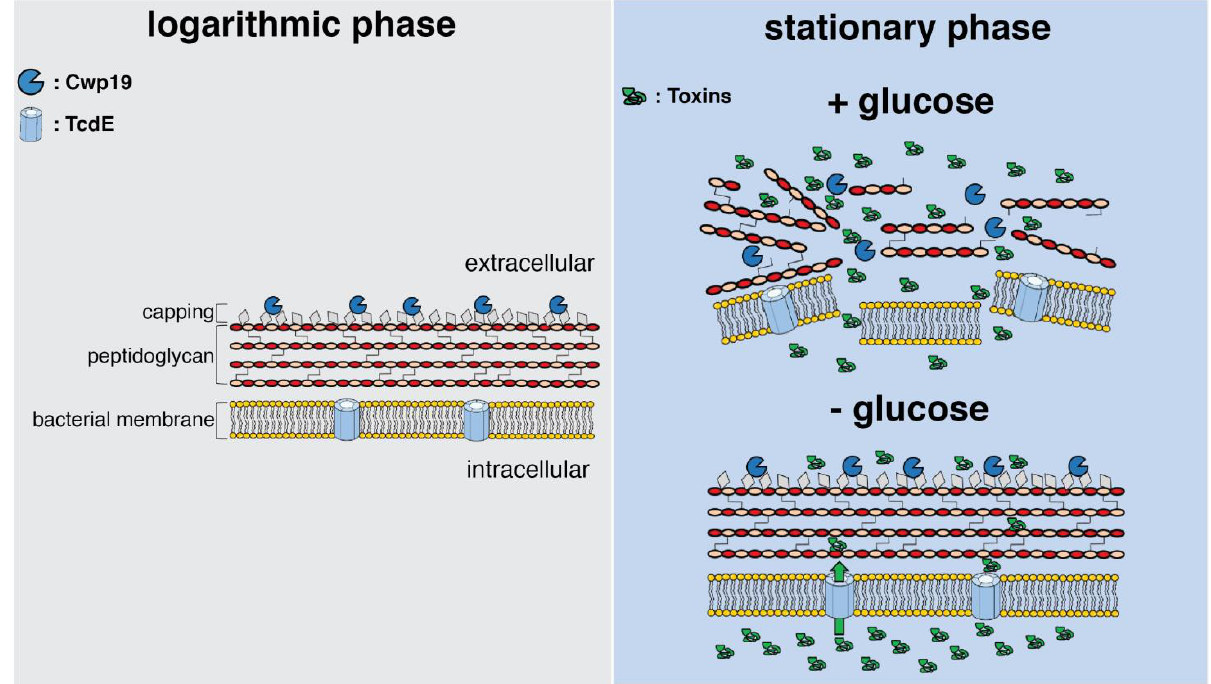
FIGURE 1: Illustration showing a model for Cwp19 activity and toxin release. Cwp19 is associated to the cell wall during logarithmic phase and active but is unable to induce cell lysis, due to peptidoglycan inaccessibility. We propose that the inability of Cwp19 to exert lytic